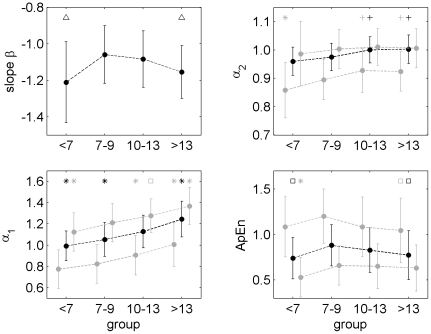
Comparison of different age groups with respect to scaling and complexity measures.Slope β – long-term fractal scaling properties, DFA α2 – intermediate-term fractal scaling properties, DFA α1 – short-term fractal scaling properties, ApEn - complexity. Each group shows three values: 24 h averages are plotted in black, night-time (left of black dot) and wake time averages (right of black dot) are plotted in grey. Note that the slope β can only be calculated for the entire recording. The symbol above a value/dot refers to comparisons within the same time period (24 h, night-time or wake time). * Group differed from 3 other groups. + Group differed from group <7 years and group 7 to 9 years. □ Group differed from group 7 to 9 years. ▵ Group differed from group 7 to 9 years and group 10 to 13 years.